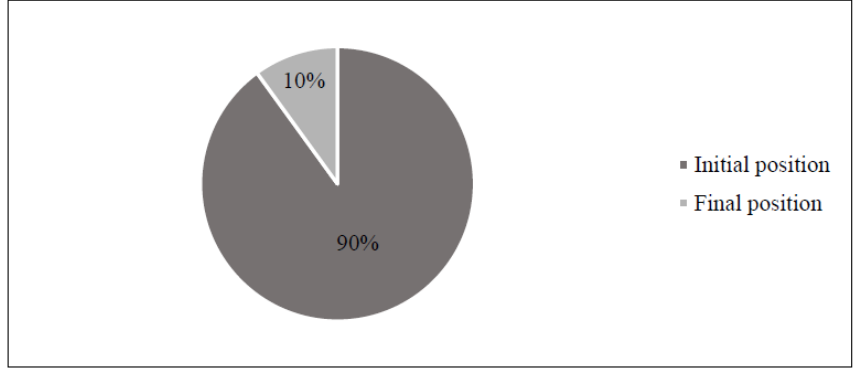
Figure 10. Percentage of use of vamos according to their position in the